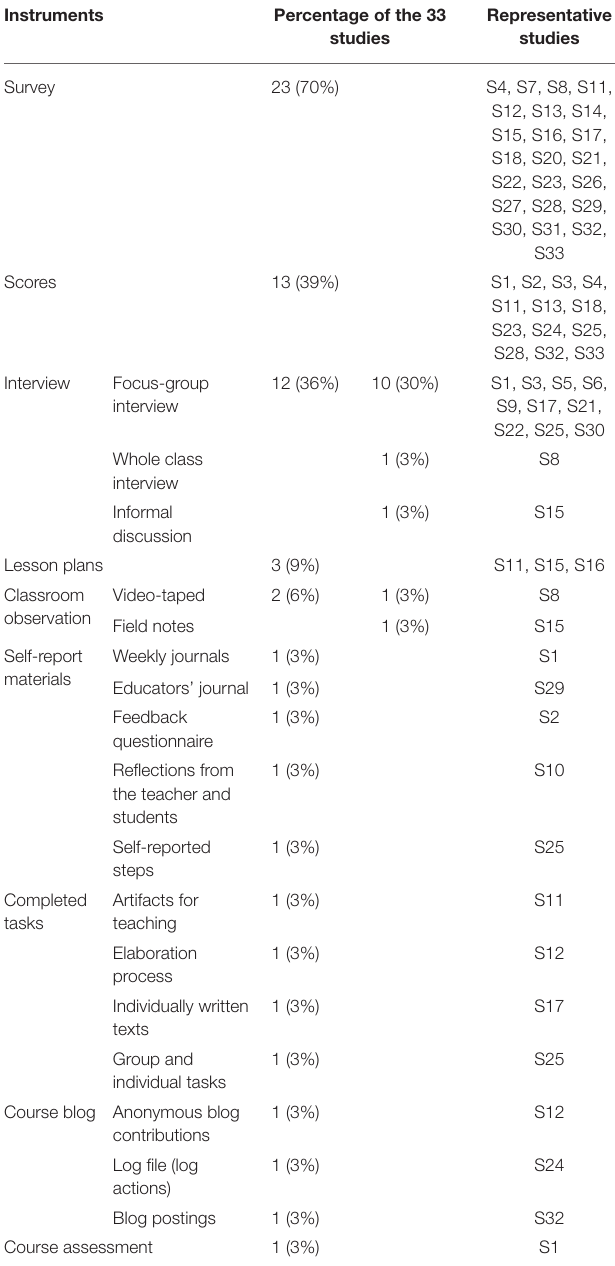
TABLE 4 | Instruments for data